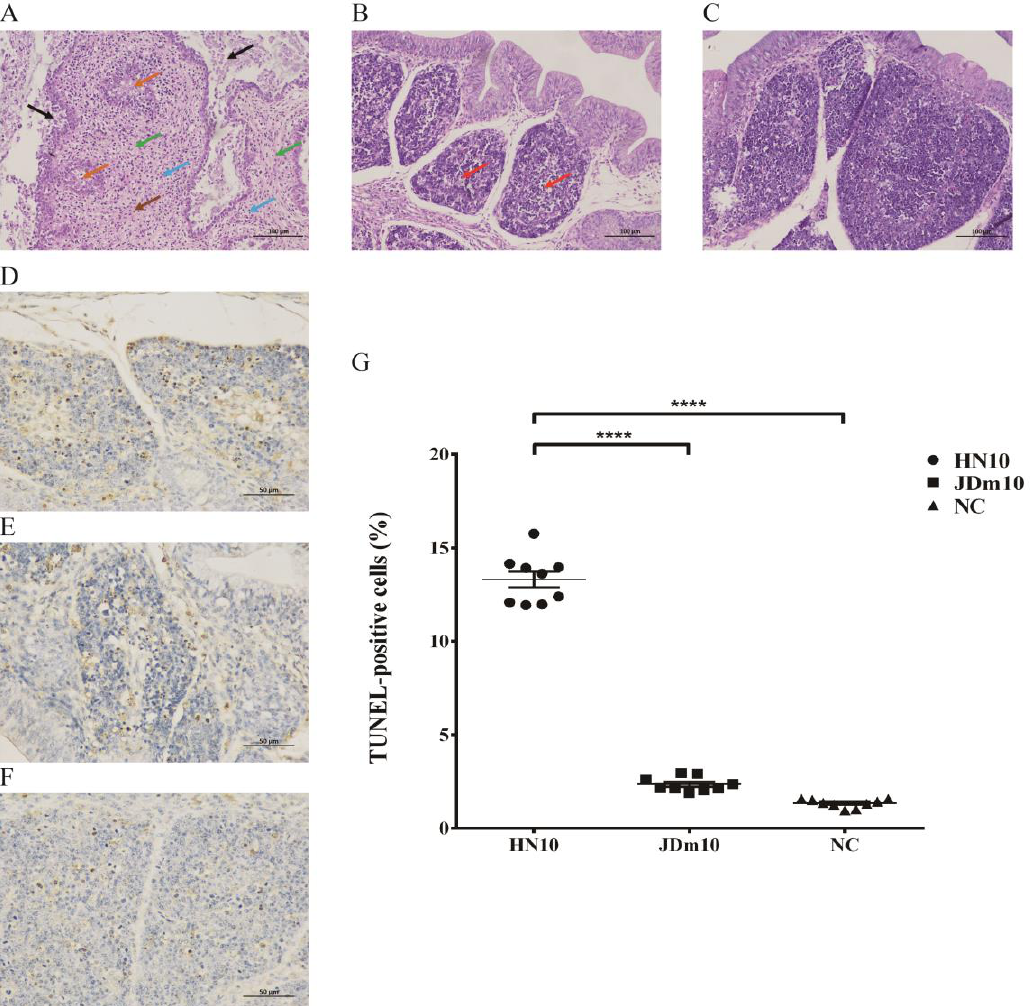
Figure 1. Microscopic lesions in the bursa of Fabricius of Muscovy ducklings inoculated with different virulent NDRV. ( A – C ) H&E staining shows the histopathological damage in the bursa of Fabricius infected by NDRV HN10 ( A ), JDm10 ( B ) and control ( C ) (Scale bar = 100 µ m, Magnification 400 × ). Black arrows indicate the necrosis and sloughing of epithelial cells in the mucosal layer; orange arrows indicate the necrosis and depletion of lymphocytes in lymphoid follicles, and follicles atrophy; brown arrows indicate the large amounts of necrotic cellular debris; blue arrows indicate the interfollicular interstitium with infiltration of neutrophils and lymphocyte; green arrows indicate the proliferation of fibrous tissues. ( D – F ) TUNEL assay shows the measurement of apoptotic cells of the bursa of Fabricius infected by NDRV HN10 ( D ), JDm10 ( E ) and control ( F ) (Scale bar = 50 µ m, Magnification 400 × ). ( G ) Percentage of apoptotic cells of the bursa of Fabricius infected with HN10 and JDm10. Data indicate mean ± SEM of 9 (control) and 9 ducklings (HN10, JDm10). One-way ANOVA with Bonferroni multiple comparison test, **** p ≤